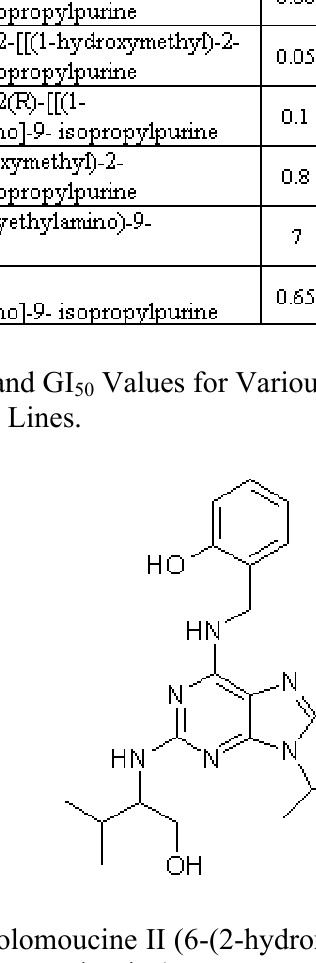
Fig. 1. Chemical structure of olomoucine II (6-(2-hydroxybenzylamino)-2[[1-(hydroxymethyl)-